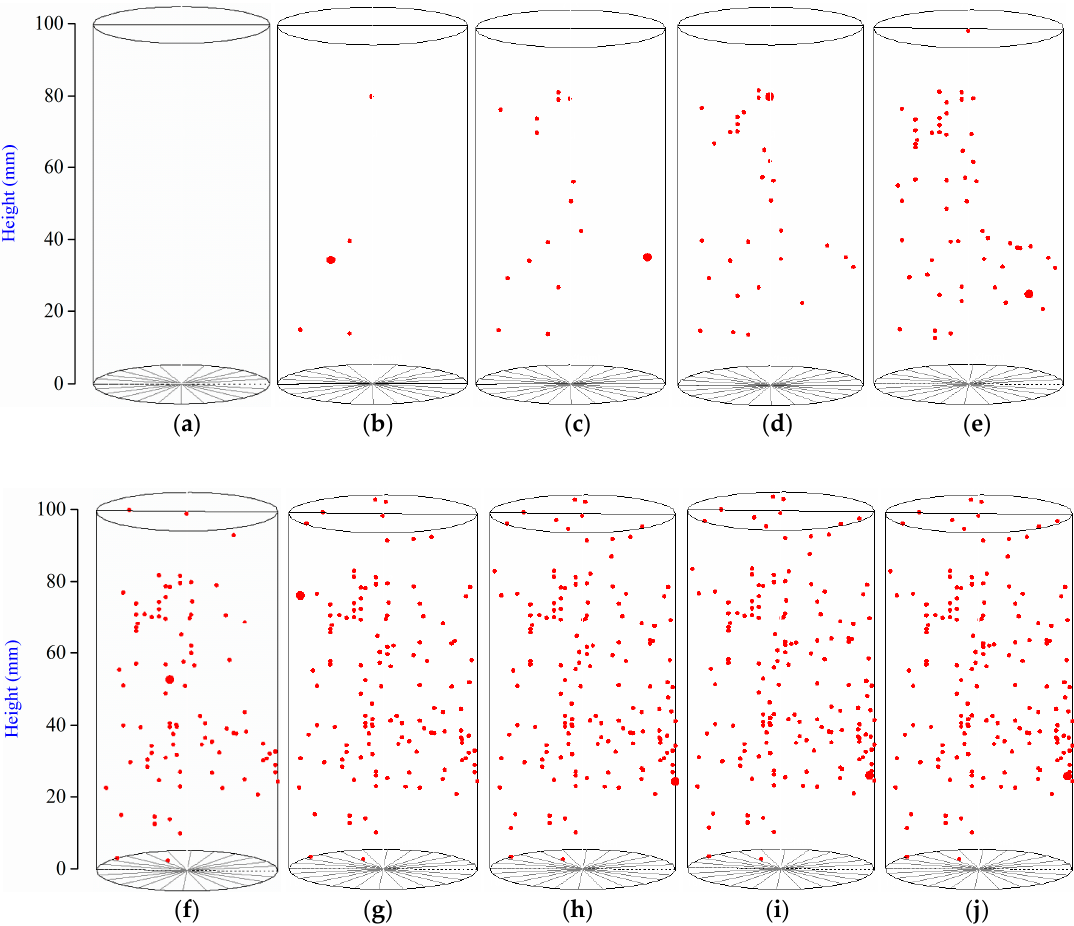
Figure 10. Distribution of AE events of the R-C-R-C-R sandwiched coal-rock specimen during the loading process. The letters shown in the figure correspond to the purple markers of Figure 7d. ( a ) 0 s; ( b ) 300 s; ( c ) 600 s; ( d ) 700 s;( e ) 800 s; ( f ) 900 s; ( g ) 1000 s; ( h ) 1100 s; ( i ) 1200 s; ( j ) 1270 s.